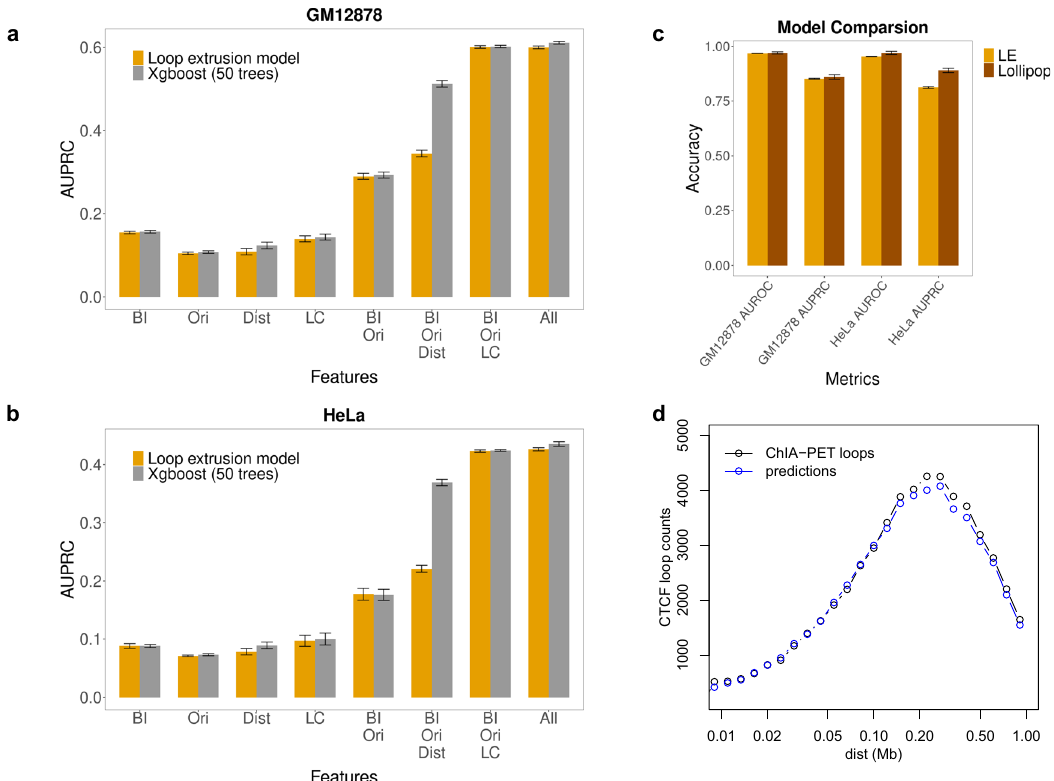
Fig. 3 Model performance evaluation and feature importance. a , b Performance of our model with different combination of features for GM12878 and HeLa. BI — CTCF-binding intensity; Ori — CTCF motif orientation; Dist — distance; LC — loop competition. Performance is also compared against xgboost model with 50 trees. Down sampling of 10% of the data was repeated 10 times and 95% con fi dence intervals are shown. c Model comparison against Lollipop under class ratio 1:5 (positive vs. negative). d Loop length distribution for measured ChIA-PET loops and predicted interacting loops are quite